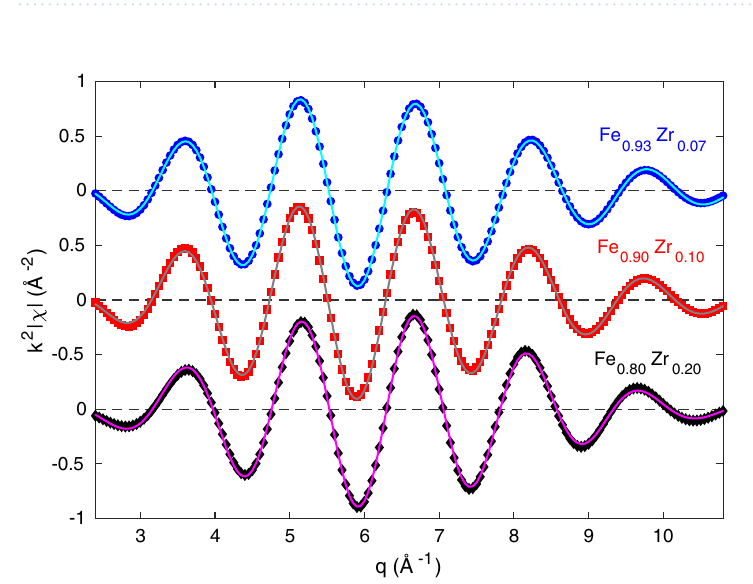
2 Figure 6. k -weighted real part of χ( q ) for experimental data (points) measured at 80 K and fits according to the four path model described in the text (lines). Both the experimental data and the fits are limited to the first shell. The back-Fourier analysis is made for R ∼ 1.5 − 2.7 Å using a Hanning window for the experimental data (corresponding to non-phase corrected distances). The data are shifted for clarity with the dashed lines indicating each zero